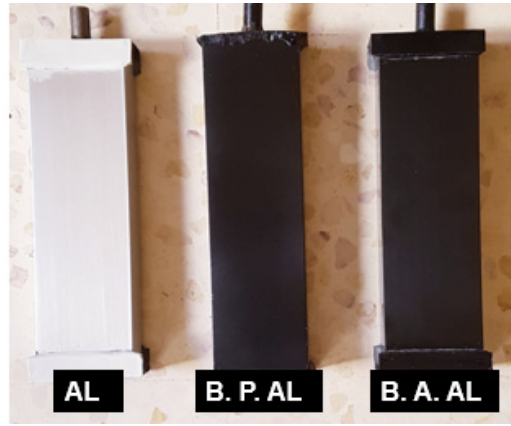
Figure 1. Three types of Al water containers: Al, B. P. Al, and B. A. Al. A digital LED light meter (type: MASTECH, MS6612T series) with a range of 0~200,000 LUX and accuracy of ± 3% was used for measuring the Global Solar Intensity (G. Solar Intensity). A TESCAN-VEGA3 Scanning Electron Microscope (SEM) and a LEICA DM 300 P optical microscope (OM) (Germany) were used for microstructure study. Two JR-1digital thermometers, with range of − 50–300 °C and accuracy ± 0.1 °C, were used for measurement of water temperature (T w ) and ambient temperature (T a ). Emery grinding papers with different grades were used for mechanical grinding, and diamond paste (2.5 µ m) and γ -alumina fine powder were used for final polishing. A potentiostat (Voltalab, PGZ 100) and VoltaMaster 4 software were used for corrosion tests. A Filmtek-3000 instrument (USA) was used to measure surface percentage light reflectance (reflectance %) (R%). A SHIMADZU UV-1601 (Japan) instrument was used to measure matte black paint transmittance % (T%) and absorptance % (Abs.%).